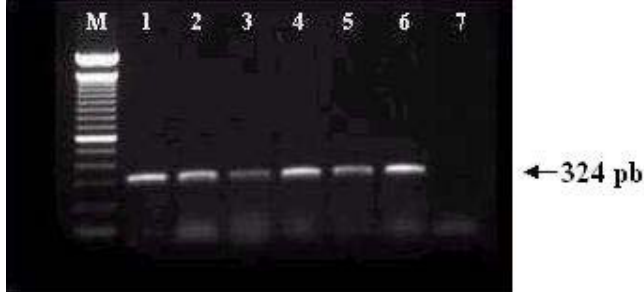
Figure 1. Detection of C. perfringens alpha toxin gene amplified by PCR. M= 100 bp molecular weight marker ladder; 1-5= clinical samples; 6= C. perfringens ATCC 3624 (Type A); 7= negative